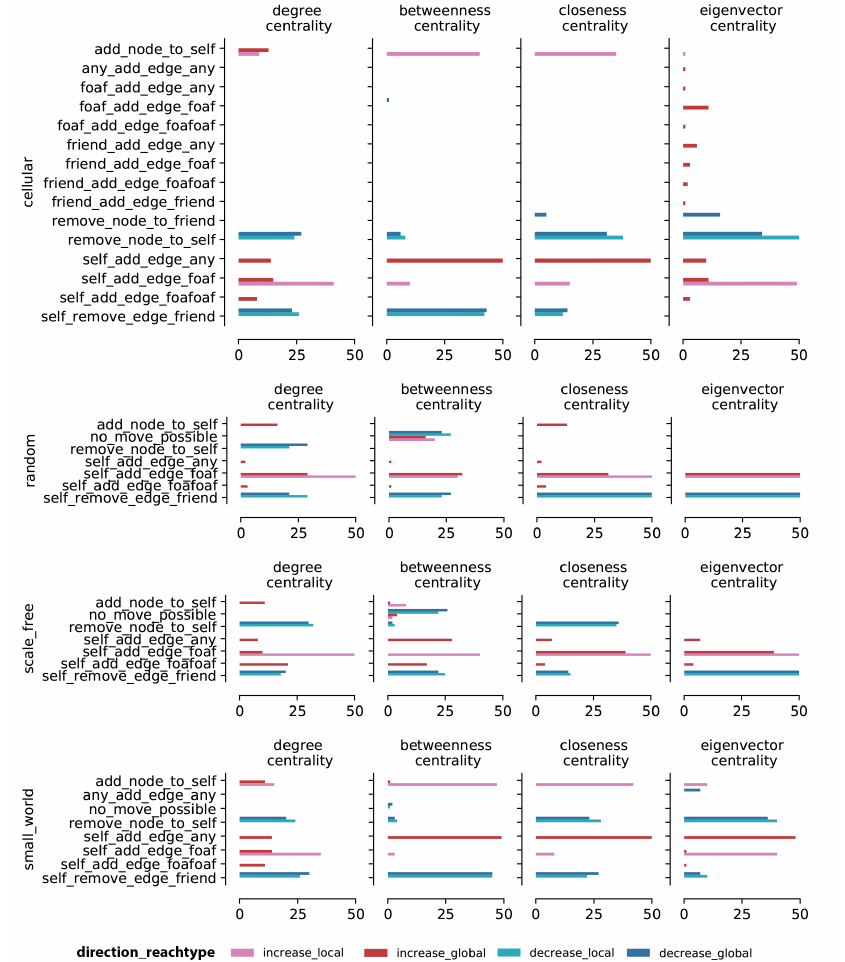
Figure 5. Optimal move counts per centrality measure and topology for large synthetic networks. The graph shows the frequency counts aggregated across 50 experiments for optimal moves for big (200 nodes) synthetic networks across different centrality measures and topologies. The x -axis shows the frequency counts for the optimal moves and the y -axis shows the different optimal